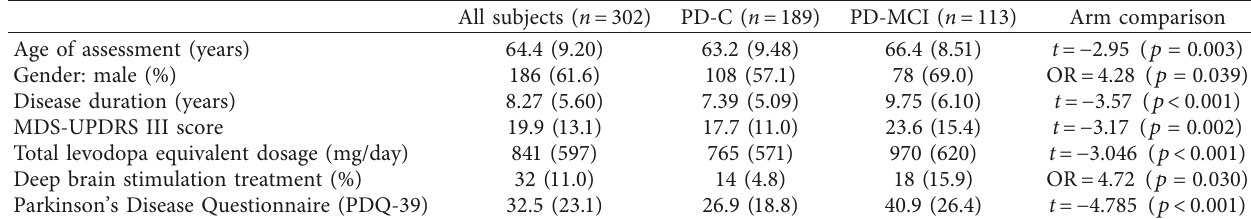
Table 2: Clinical and demographic characteristics of cohort, when grouped by cognitive